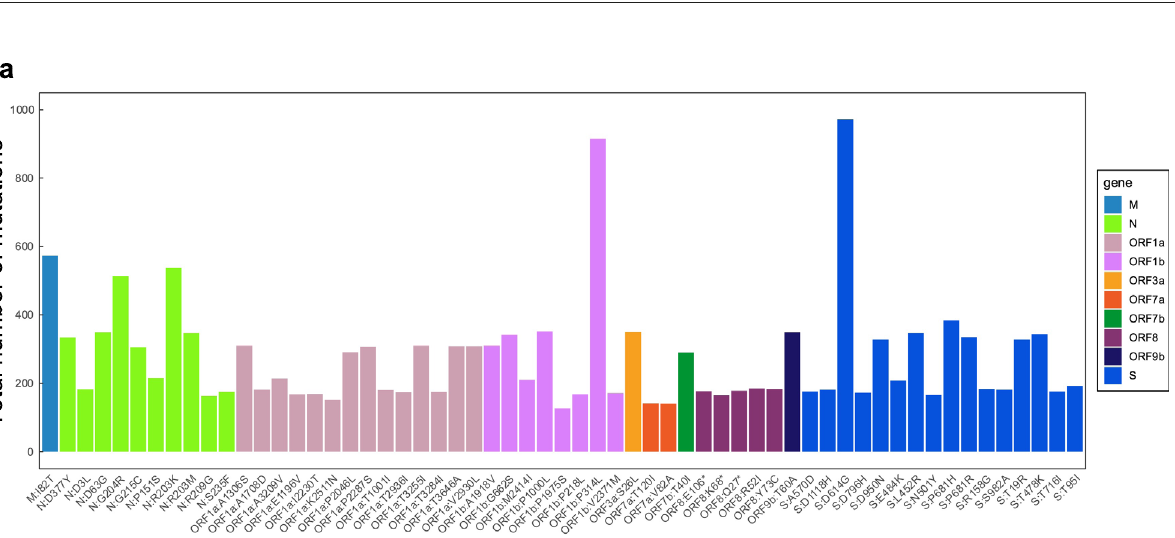
Fig. 3 Genetic diversity and molecular evolutionary relationships of variants identi fi ed in Ghana. a The spread/range and magnitude of mutation per lineage ( n = 1002). Each fi lled circle represents a sample, and the circle ’ s width is proportional to the number of mutations present in a particular sample. b Maximum likelihood phylogenetic tree with ancestral state reconstruction in a backdrop of reference sequences from Wuhan and evolutionary relationship of the Ghanaian variants over time ( n = 1002). Colours show the VOC; Delta lineages, Alpha, B.1.1.318, and Beta, based on Nextstrain ’ s emerging lineages designations. c Root-to-tip divergence as a function of sampling time. The Y -axis denoted divergence (the number of mutations in the genome relative to the root), and the X -axis shows the sampling date of each genome. d Annotated mutational fi tness of all the B.1.1.318 lineage in Ghana; the samples with the highest fi tness are coloured red.